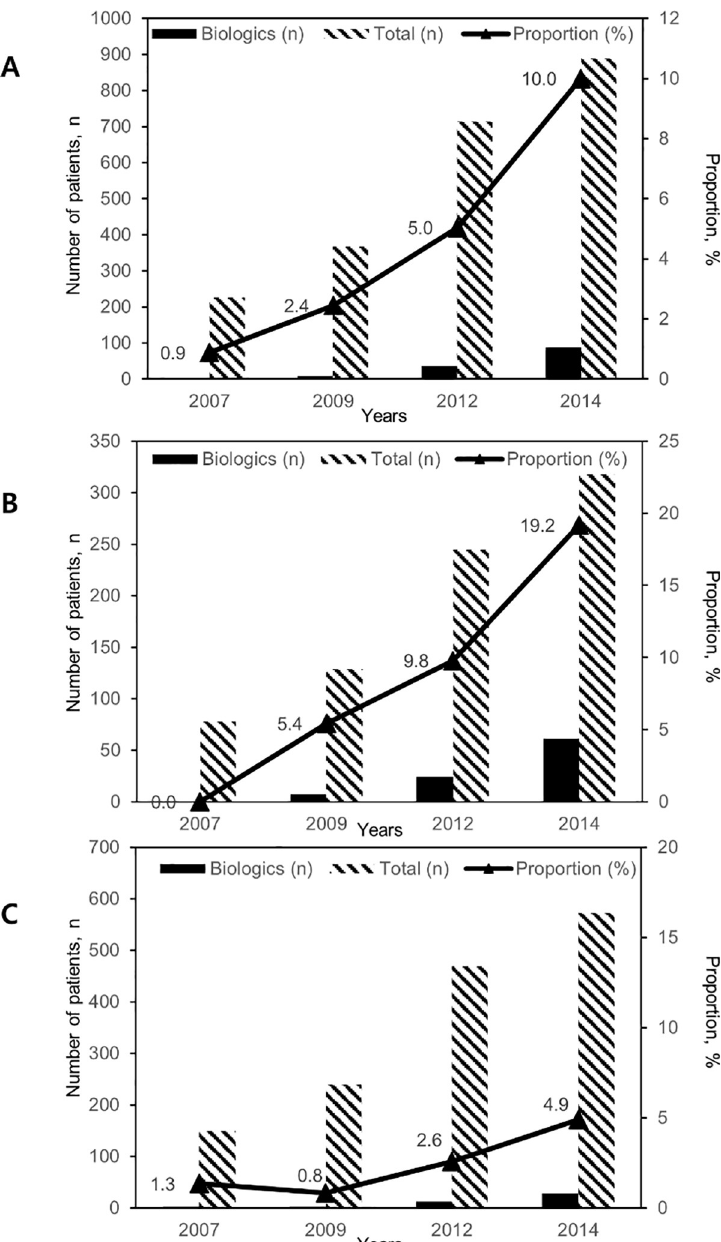
Fig 3. The number and proportion of patients with IBD (A), CD (B), and UC (C) treated with biologics stratified by years. The number and proportion of IBD patients who had received or under treatment with biologics increased from 2007 to 2014 ( P <